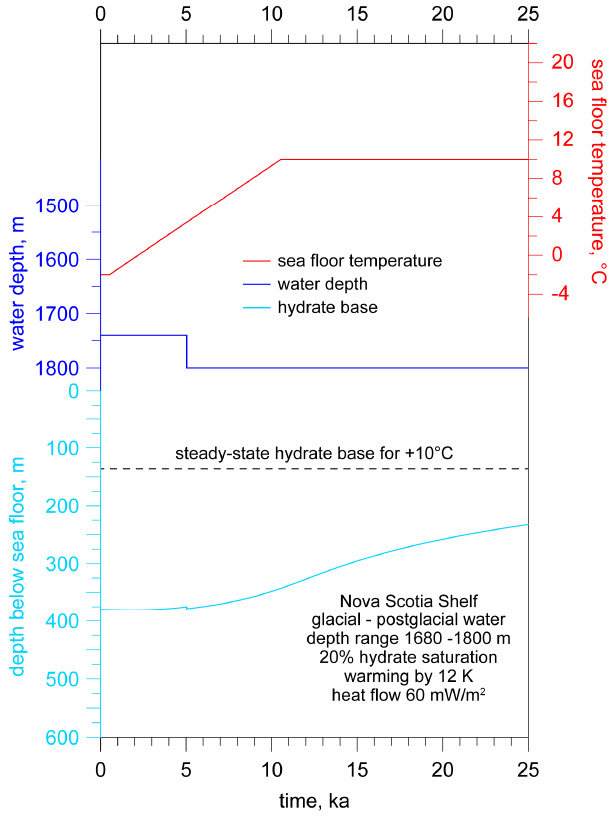
Figure 17. Atlantic Margin marine GH history models for current a 1680–1800 m water